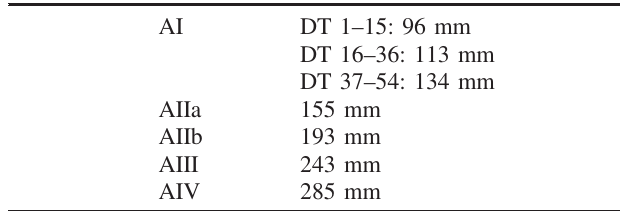
TABLE II. Effective lengths of the DTL